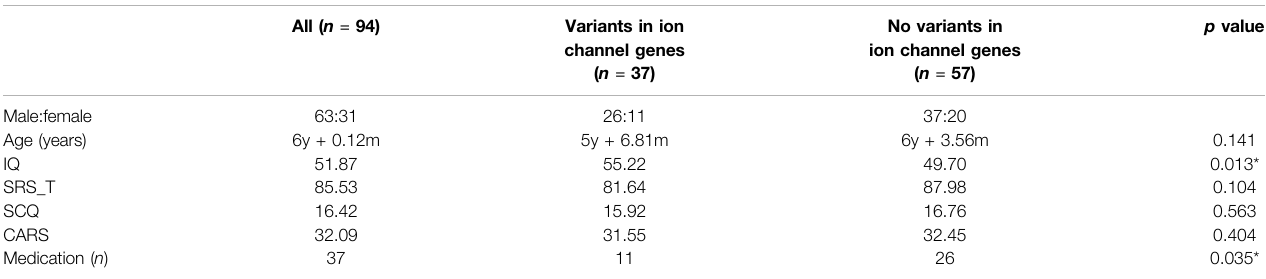
TABLE 1 | Demographic and clinical data for children with ASD and group comparisons.